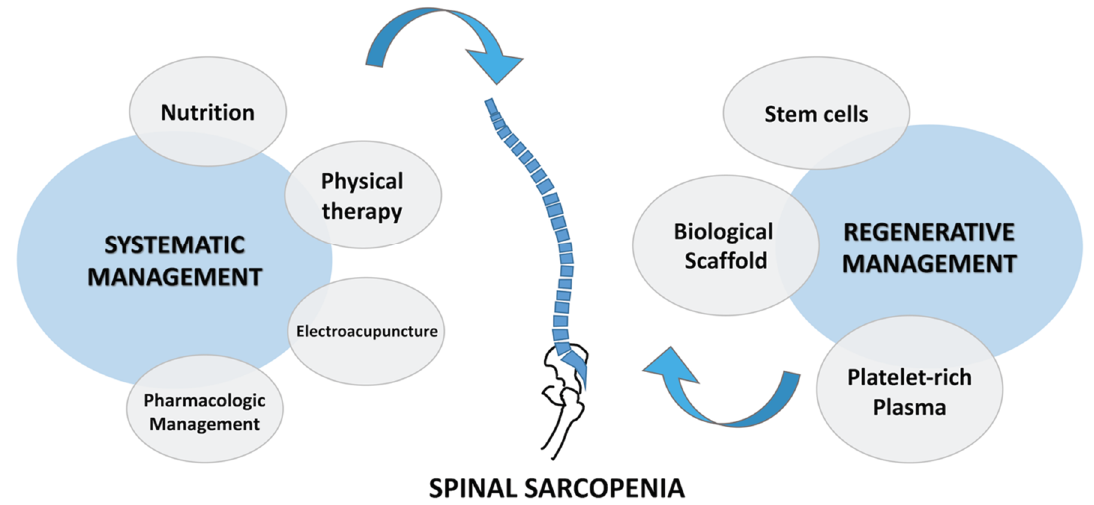
Figure 3. Conventional and regenerative management of spinal sarcopenia. PRP: platelet-rich plasma.